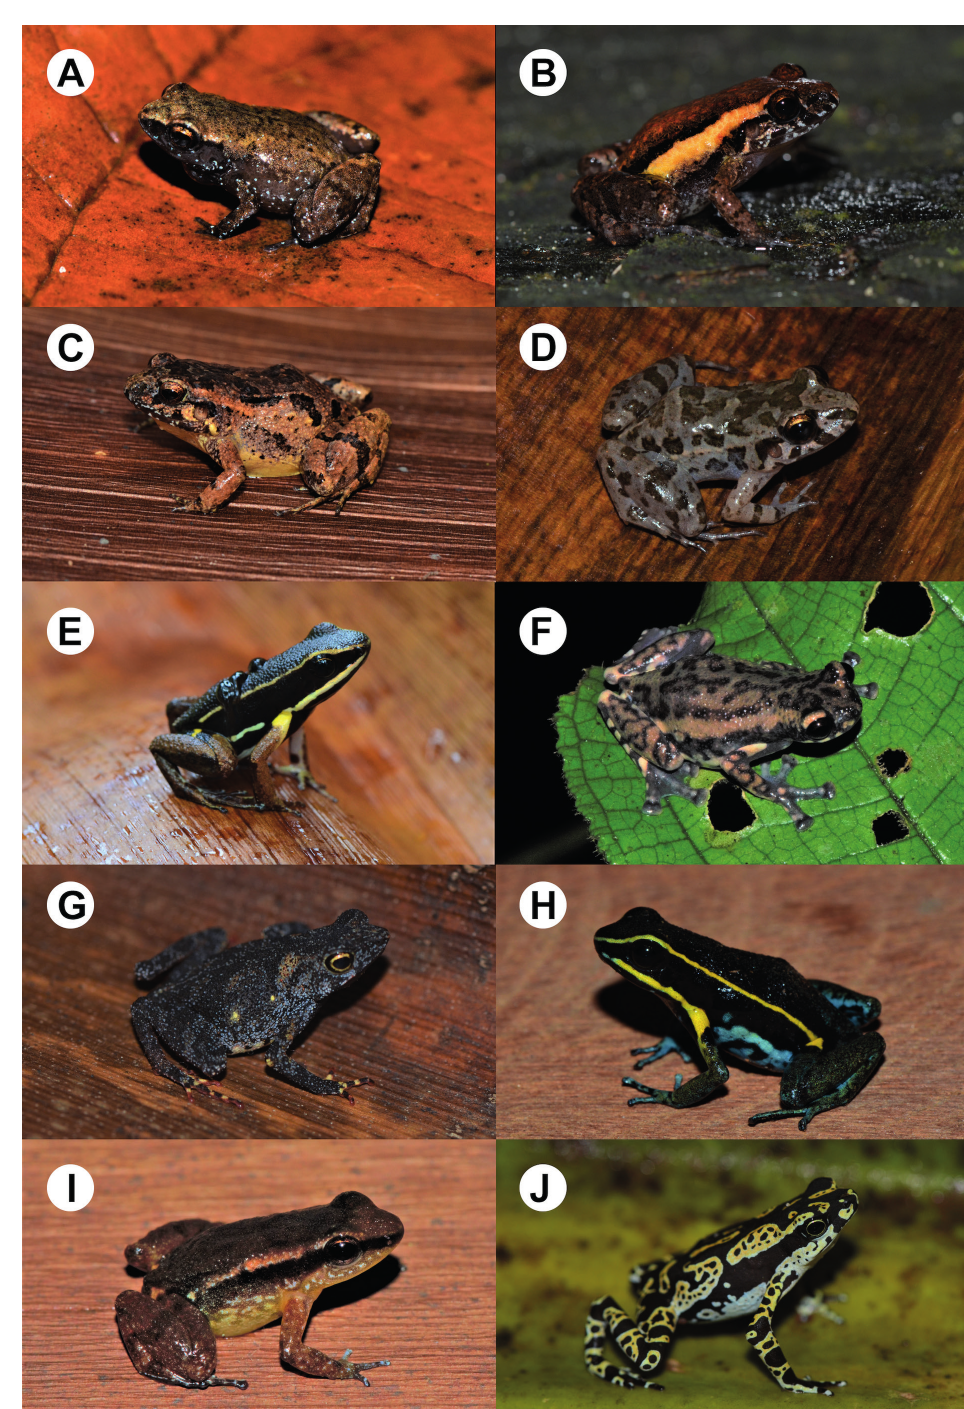
Fig. 1. Anuran species recorded in the state of Amapá. A . Adelophryne amapaensis Taucce, Costa- Campos, Haddad & Carvalho, 2020. B . Adenomera andreae Müller, 1923. C . Adenomera heyeri Boistel, Massary & Angulo, 2006. D . Adenomera hylaedactyla (Cope, 1868). E . Allobates femoralis Boulenger, 1884. F . Allophryne ruthveni Gaige, 1926. G . Amazophrynella teko Rojas, Fouquet, Ron, Hernández- Ruz, Melo-Sampaio, Chaparro, Vogt, Carvalho, Pinheiro, Ávila, Farias, Gordo & Hrbek, 2018. H . Ameerega pulchripecta (Silverstone, 1976). I . Anomaloglossus baeobatrachus (Boistel & Massary, 1999). J . Atelopus hoogmoedi Lescure, 1974. Photos: C.E.